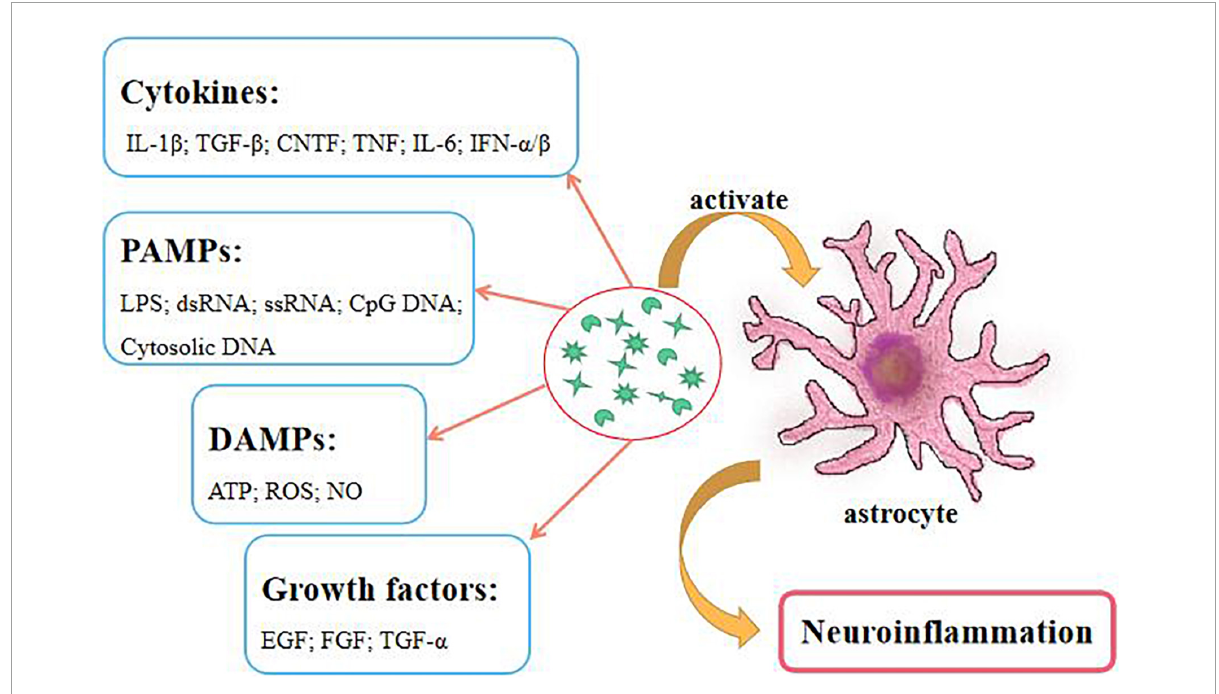
FIGURE1 Numerous factors activate astrocytes to cause